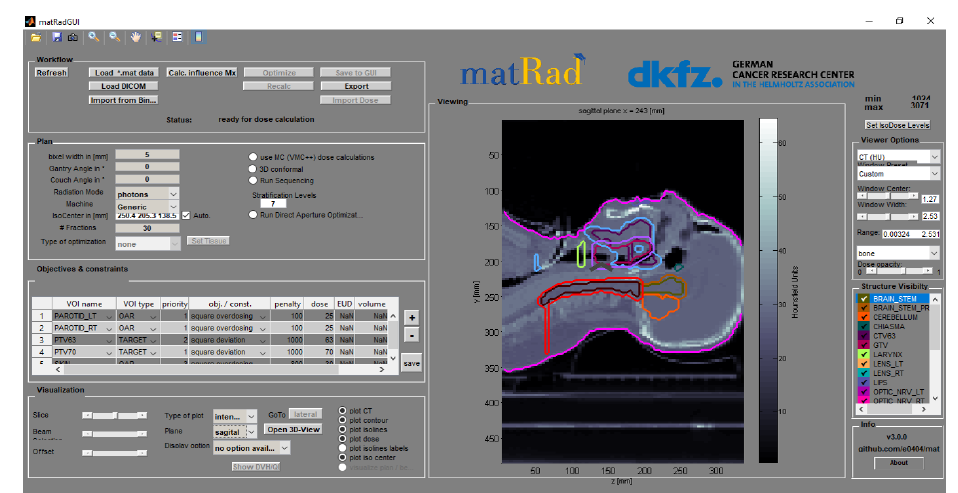
Fig. 3: Main window of the Particle Therapy Masterclass showing therapy planning for the head tumour